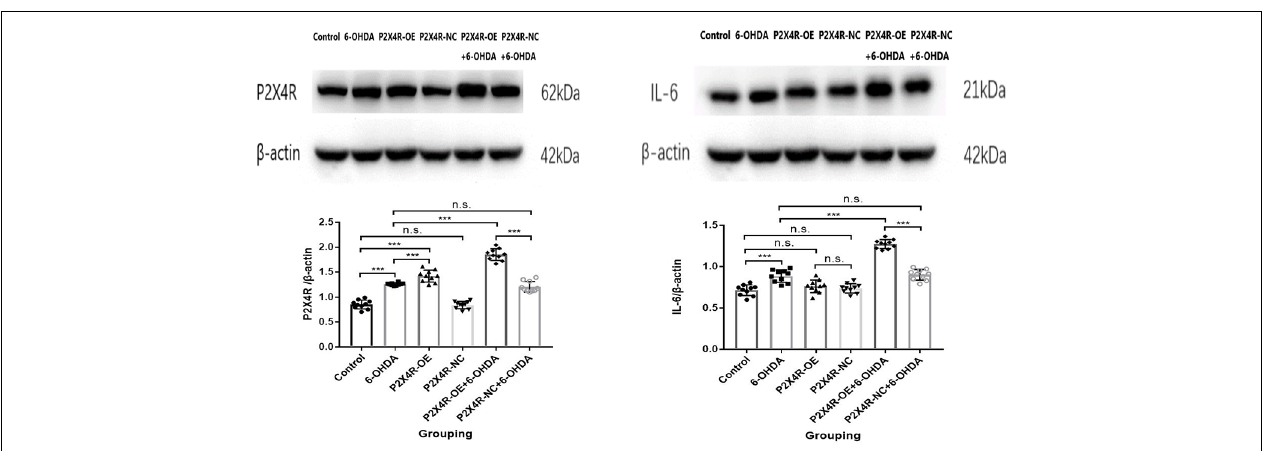
positive DA neurons of P2X4R-OE + 6-OHDA group decreased significantly ( P < 0.001). There was no significant difference in TH positive DA neurons between the control group, the P2X4R-NC group, and the P2X4R-OE group ( P >